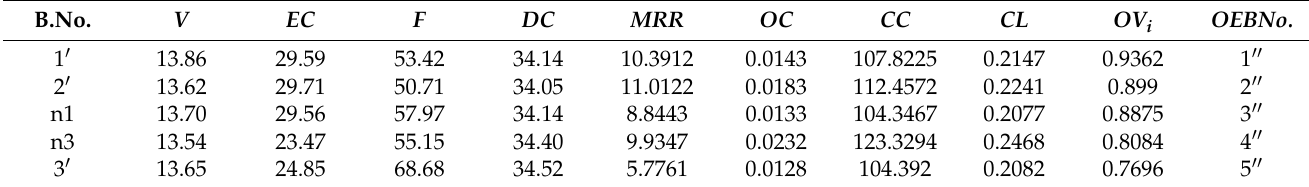
Table A10. Outcome of employed